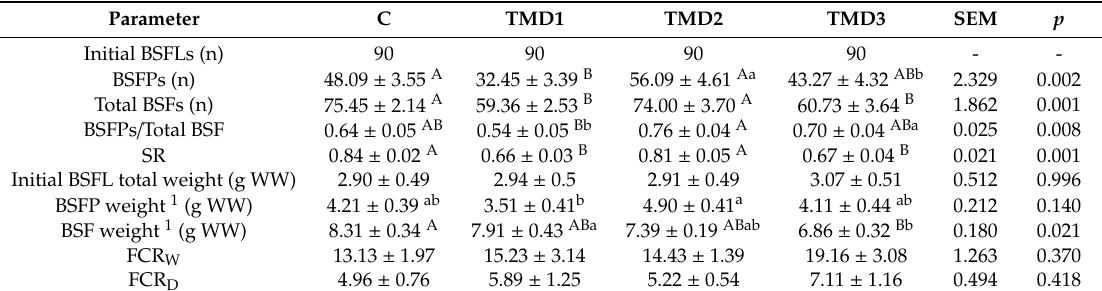
Table 4. E ff ect of the diets on larval survival and development, black soldier fly prepupae (BSFPs), and total yields and feed conversion ratios